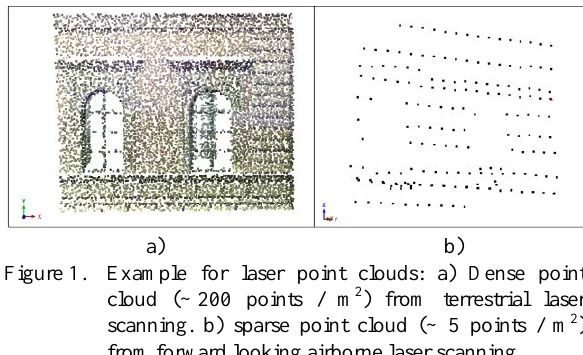
Figure 1. Example for laser point clouds: a) Dense point cloud (~ 200 points / m 2 ) from terrestrial laser scanning. b) sparse point cloud (~ 5 points / m 2 ) from forward looking airborne laser